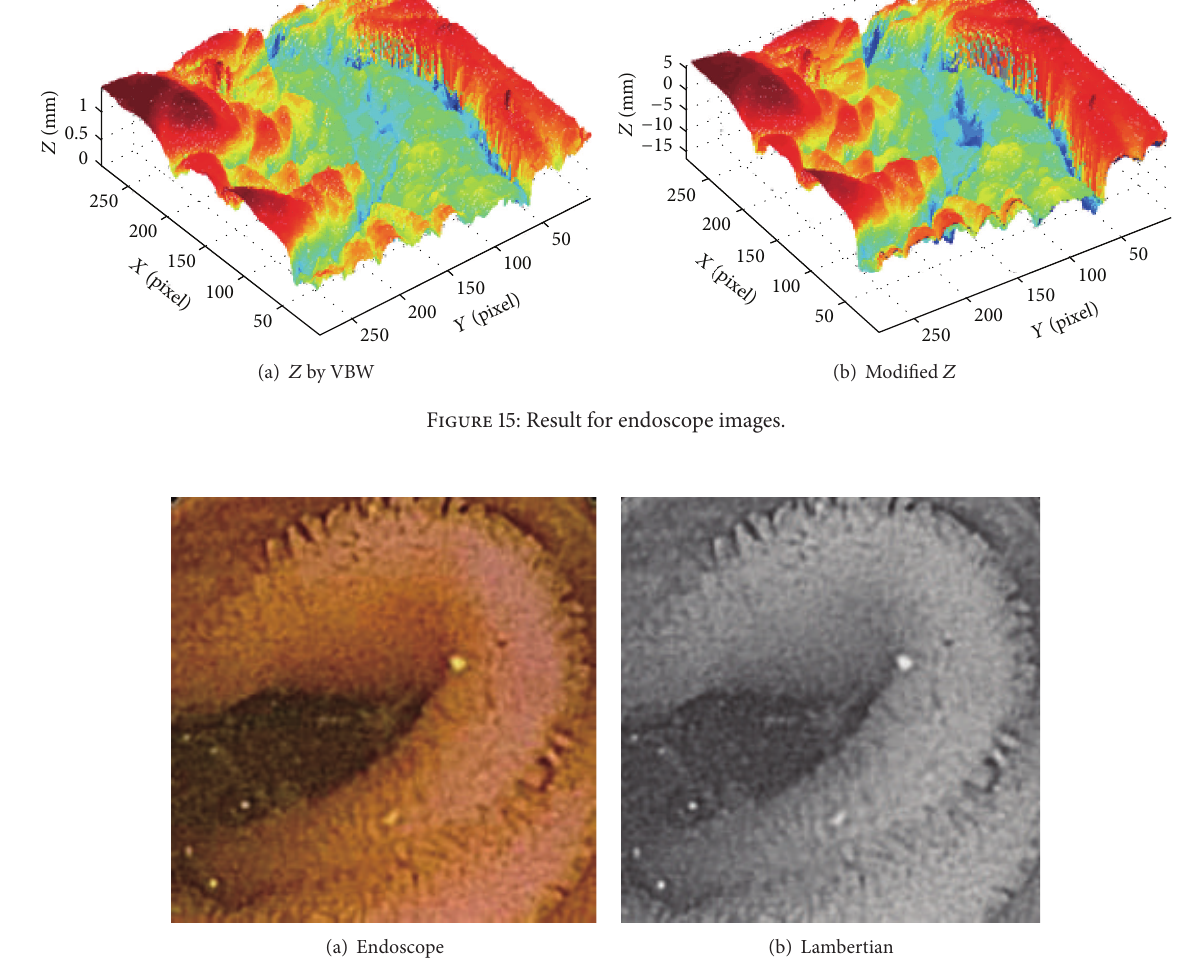
Figure 16: Endoscope image and generating Lambertian